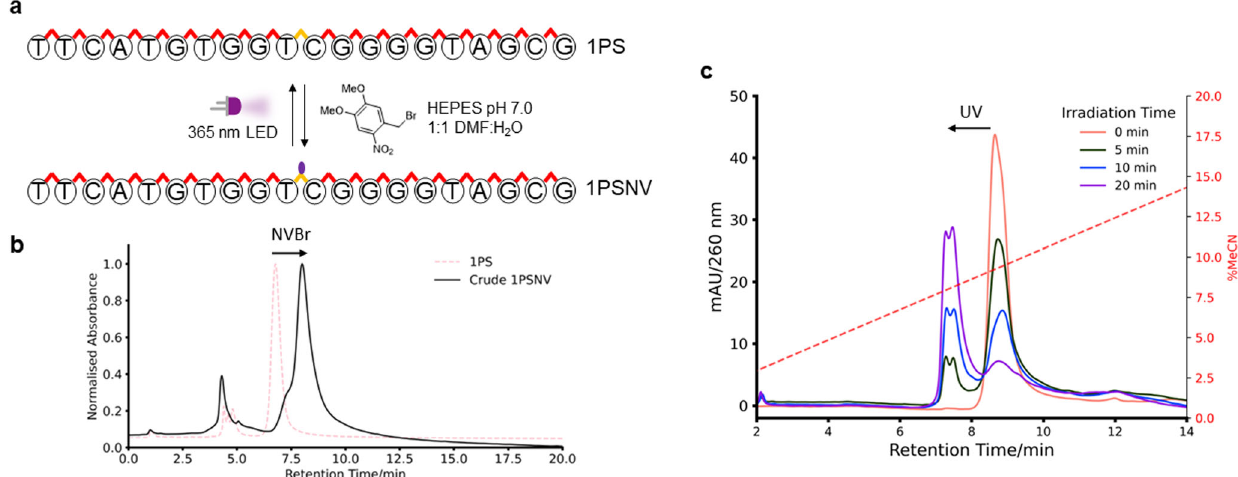
Fig. 2 Reaction conditions for modi fi cation of PS-linkages with 2-nitroveratryl bromide and photocleavage of the reaction product. a Optimal reaction conditions found for the modi fi cation of a PS-containing oligonucleotide and its corresponding photocleavage. b Crude chromatogram of the reaction after ethanol precipitation. c Photocleavage of the HPLC-puri fi ed 1PSNV oligonucleotide monitored by